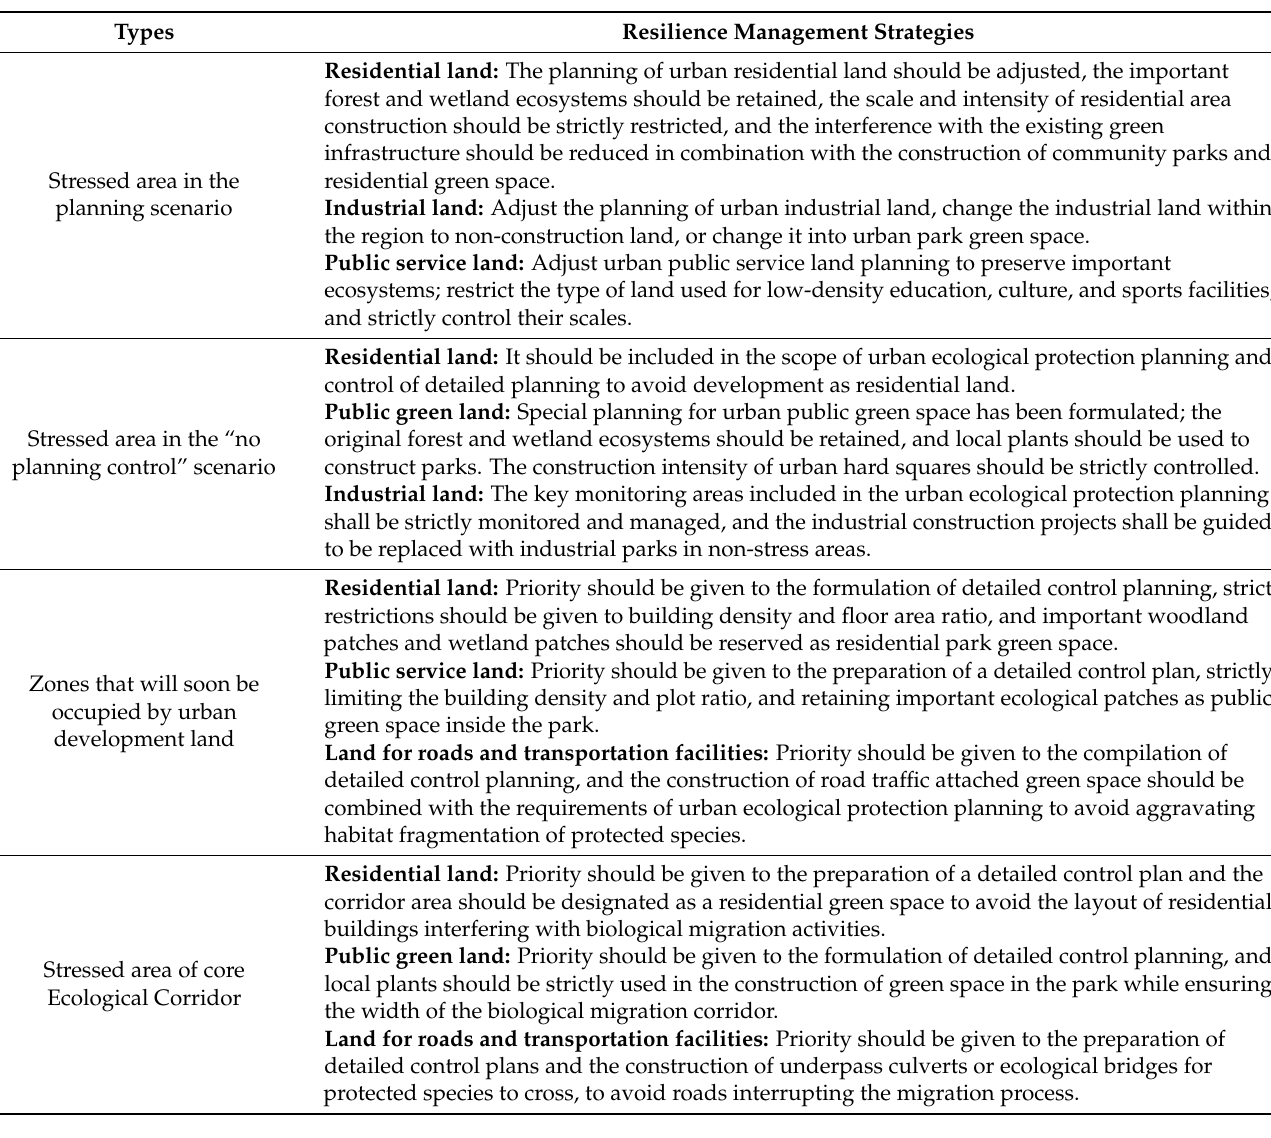
Table 8. Measures to improve the resilience of the stressed green